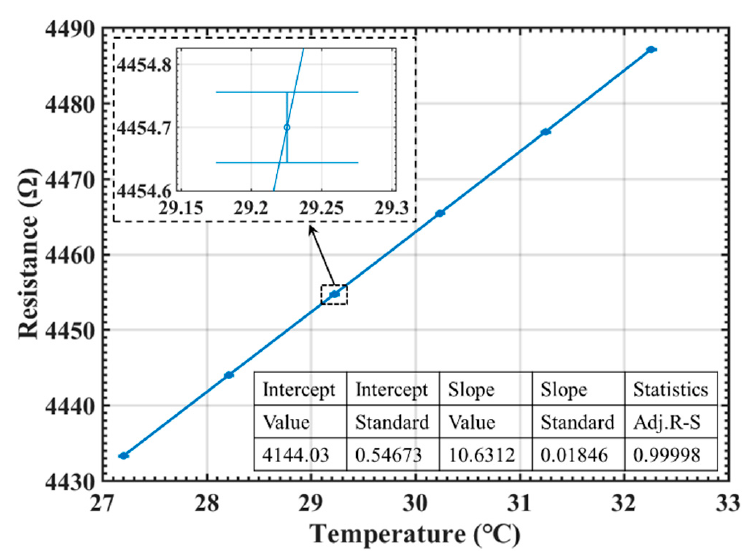
Figure 5. Fitting R and T curves.